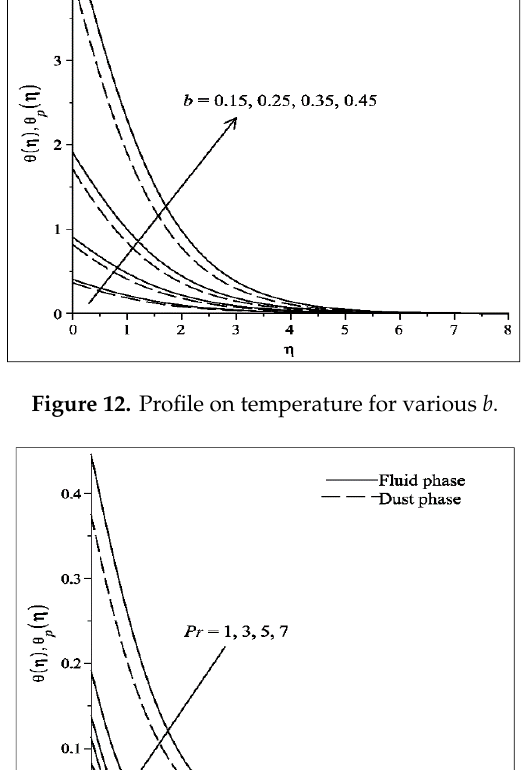
Figure 11. Profile on temperature for various Gr .